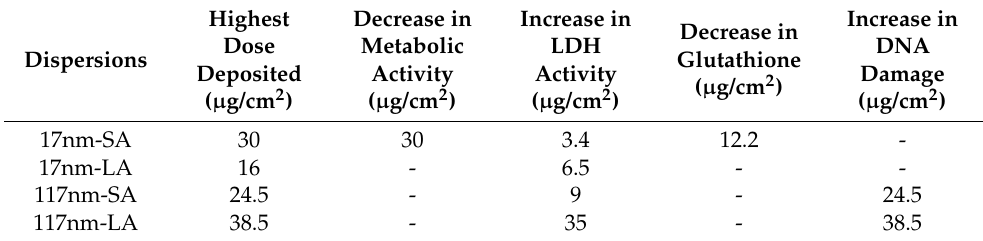
Table 3. Significant lowest observed adverse effect concentration of different TiO 2 agglomerates observed for different biological endpoints at the ALI. “-“ indicates no significant effect could be detected.